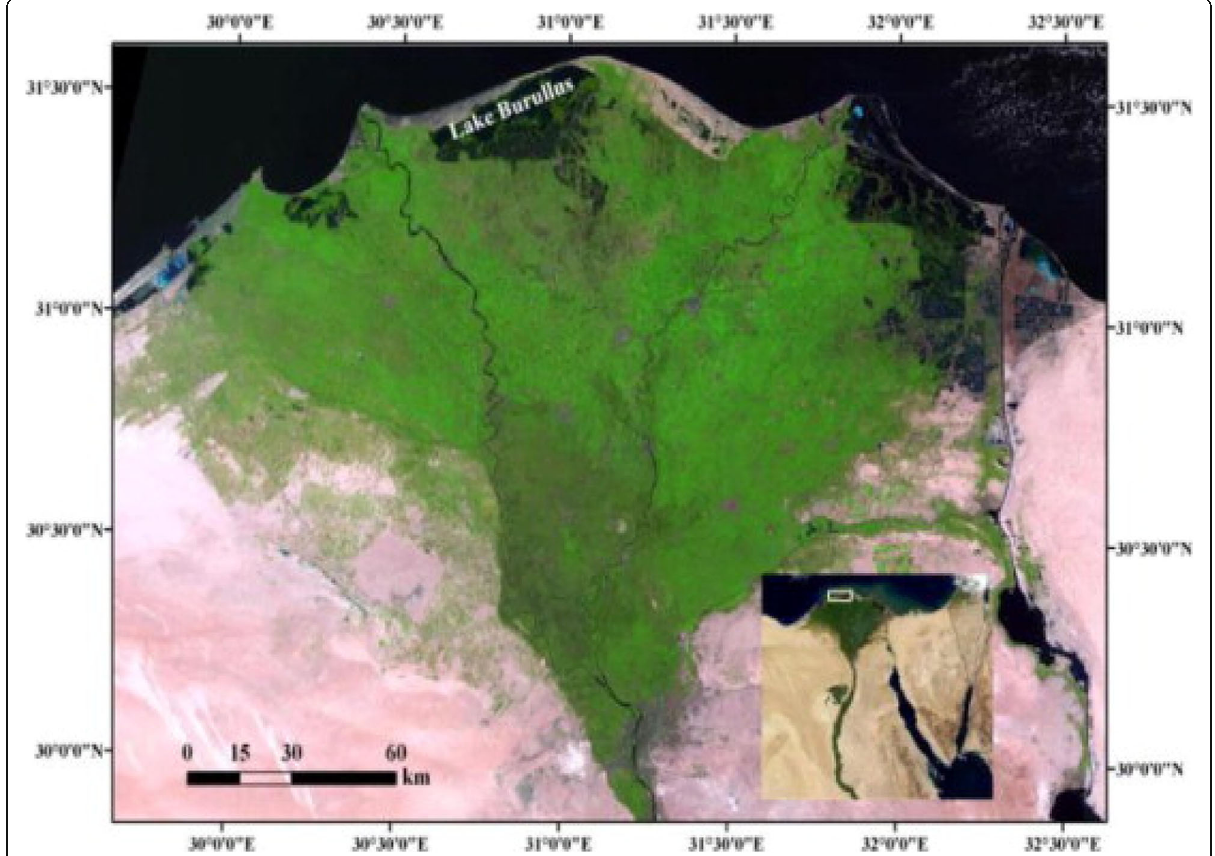
Fig. 1 A Landsat image of the Nile Delta showing the location of Lake Burullus. a By using free satellite imagery data sources. b The study area of El-Burullus lagoon brackish water (31° 22 ′ − 31° 26 ′ N and 30° 33 ′ − 31° 07 ′